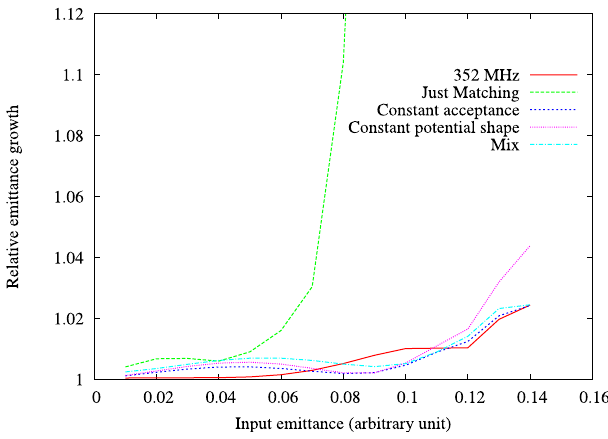
FIG. 2. (Color) The relative emittance growths for an increasing input longitudinal emittance for the four